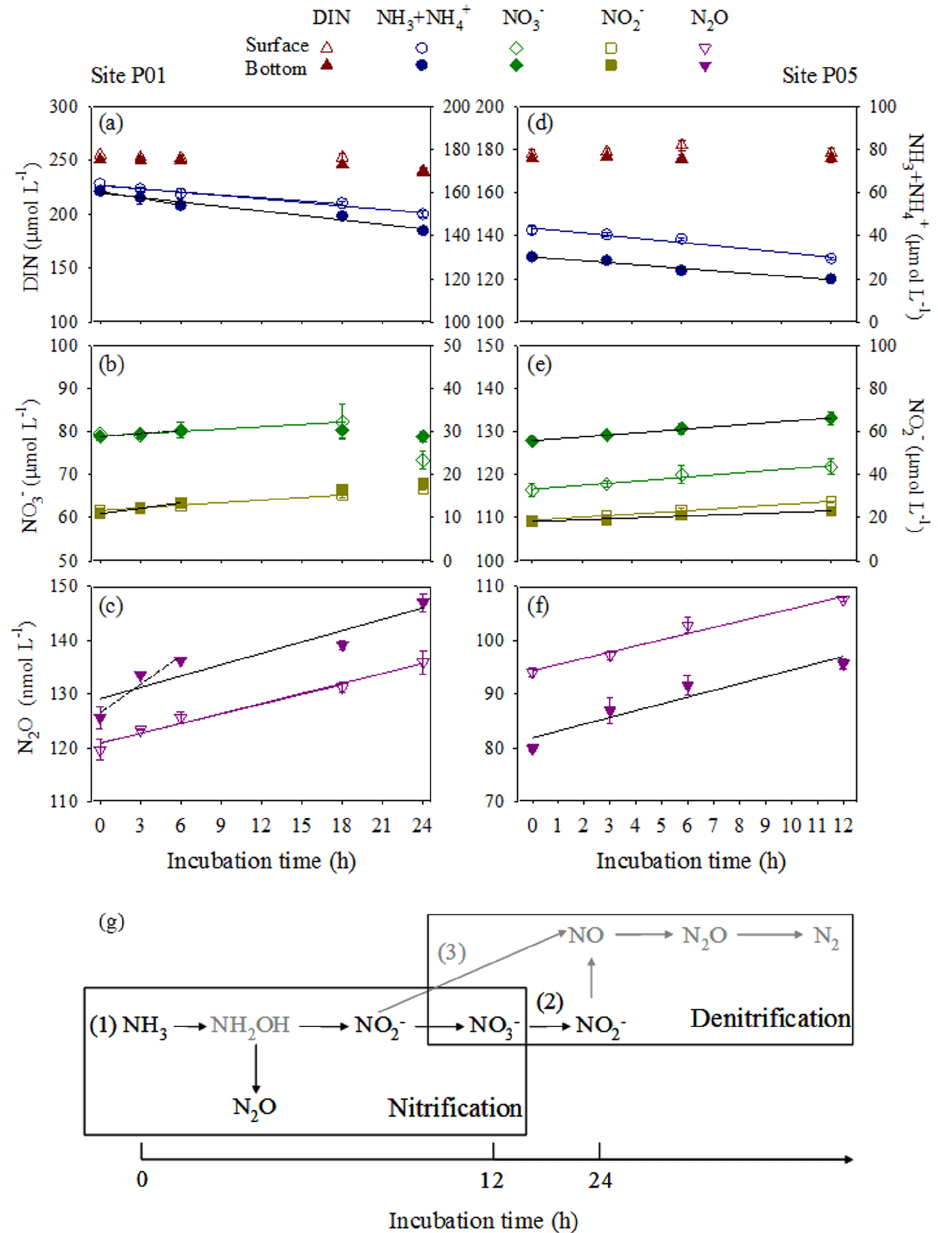
Figure 5. Variations in nitrogen compounds and N 2 O concentrations at sites P01 and P05 during the incubation experiments in surface (open symbols) and bottom (closed symbols) waters. (a, d) Total DIN (brown triangles) and NH 3 + NH + (blue circles), (b, e) NO − (green 4 3 diamonds) and NO − (dark yellow squares), and (c, f) N 2 O (purple inverted triangles). Linear regressions depend on whether variations in 2 DIN concentration against time retain mass balance in a closed incubation system. The linear regressions of ammonia were used to estimate ammonia oxidation rates in (a) P01 over 18 and 24h (surface water, blue lines) and 6 and 24h (bottom water, black lines), as well as (d) P05 over 12h (surface, blue line; bottom, black line). The linear regressions of nitrate estimated nitrite oxidation rates in (b) P01 over 18h (surface water, green line) and 6h (bottom water, black line), as well as (e) P05 after 12 h (surface, green line; bottom, black line). The nitrite linear regressions after 18h (surface water, dark yellow line) and 6h (bottom water, black line) in P01 and 12h (surface, dark yellow line; bottom, black line) in P05 are also shown but do not indicate oxidation rates. The N 2 O linear regressions were used to estimate N 2 O production rates in (c) P01 after 18 and 24h (surface water, purple lines) and 6 and 24h (bottom water, black lines; dashed line, no statistical significance test), as well as (f) P05 after 12h (surface, purple line; bottom, black line). All regression equations, R 2 values, and P values are shown in Table 2. (g) A diagram showing transformations of nitrogen compounds and N 2 O production during incubation experiments. Nitrification (1) occurred during the entire P01 and P05 incubations and denitrification (2 and/or 3) may be present in the end phase of the P01 incubation. The gray arrows indicate the pathways of nitrogen loss not analyzed here, and the gray compounds indicate the unmeasured nitrogen